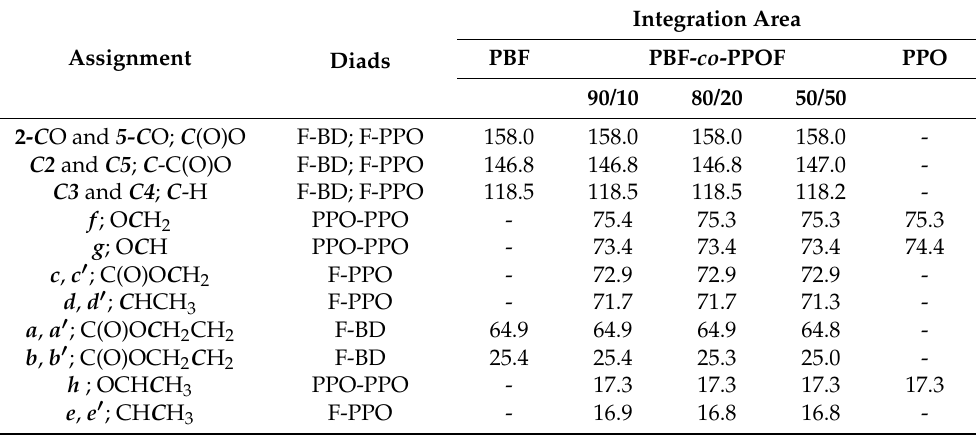
Table 4. Main 13 C NMR resonances of all PBF- co -PPOF co-polyesters, and PBF and PPO homopolyester. The a, b, c, d, e, f, g and a (cid:48) , b (cid:48) , c (cid:48) , d (cid:48) , e (cid:48) attributions are explained in the scheme of Figure